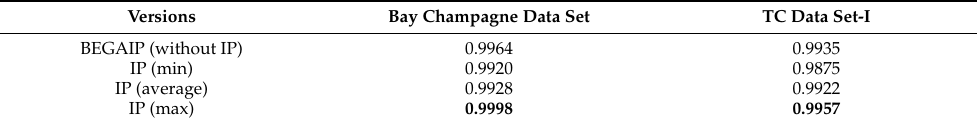
Table 3. AUC values of IP with different pooling on data